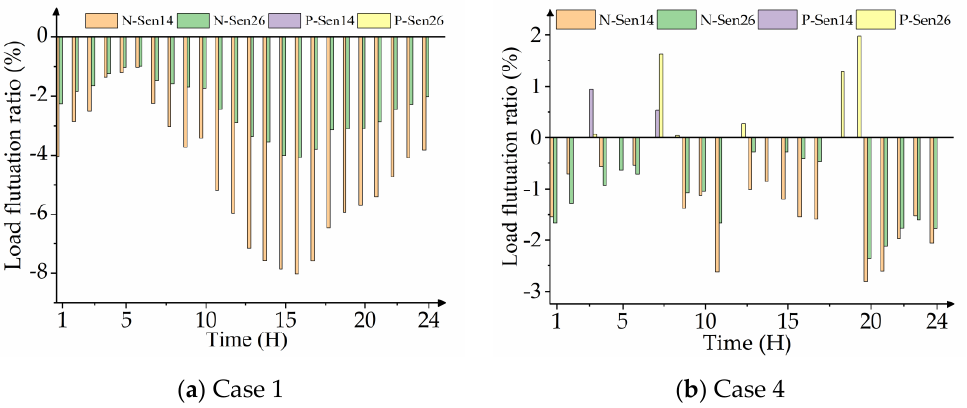
Figure 5. The daily load fluctuation ratios of the bus 14 and bus 26 in case 1 ( a ) and case 4 at scene 3 ( b ).